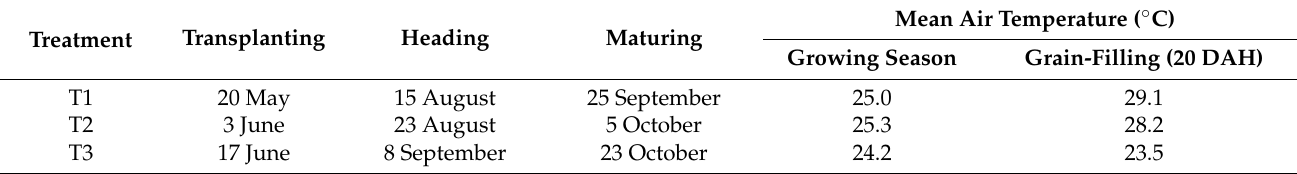
Table 1. Dates of growth stages and mean air temperature for the three treatment groups. Treatment Transplanting